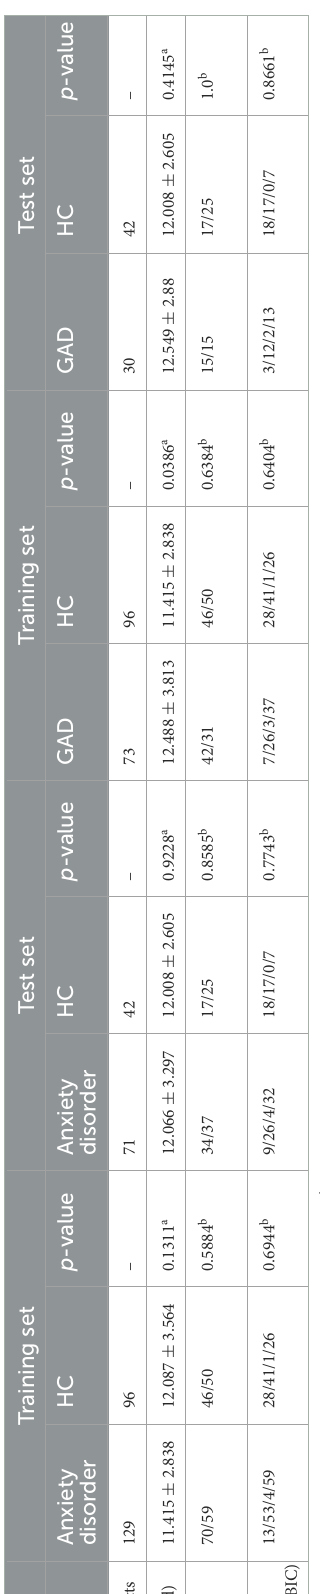
and tested using the abovementioned selected radiomics features. The model performance was evaluated by the area under curve (AUC) of the receiver operator curve (ROC) for the classification of diagnostic